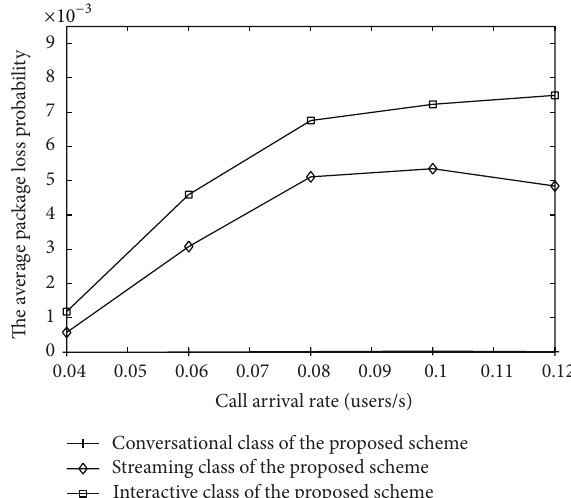
Figure 16: The package loss of IDMA system.